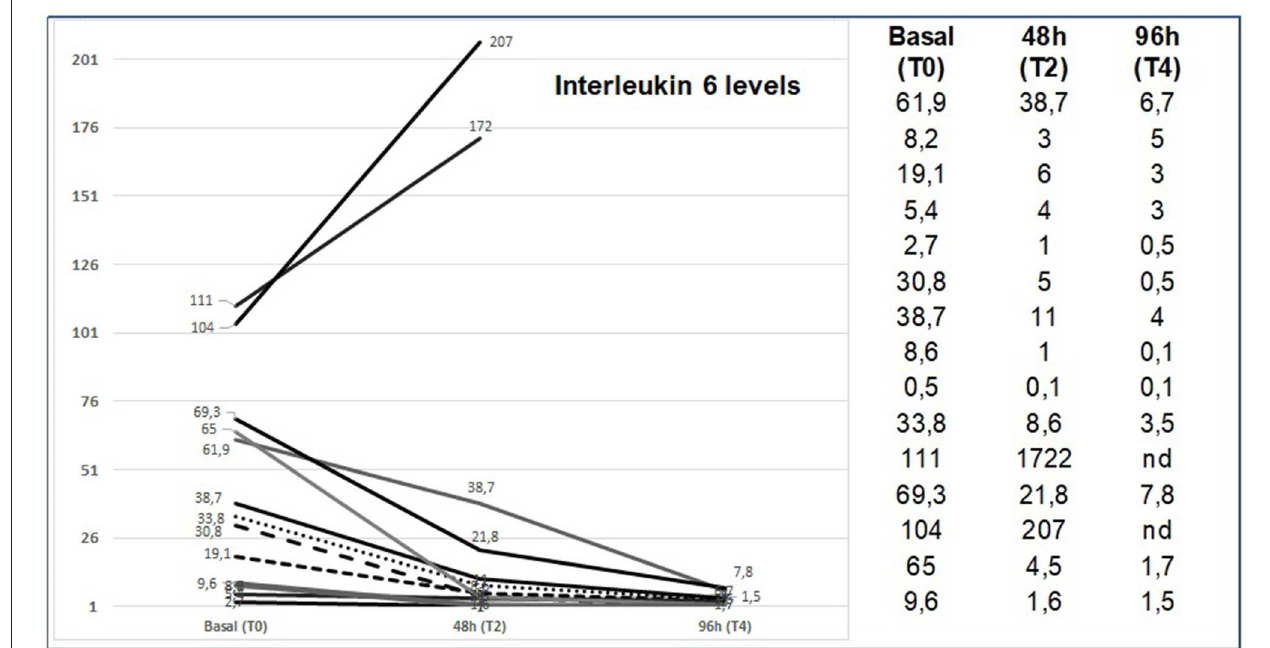
FIGURE 2 | IL6 levels at baseline, after 24, 48, and 96h from starting ruxolitinib treatment.